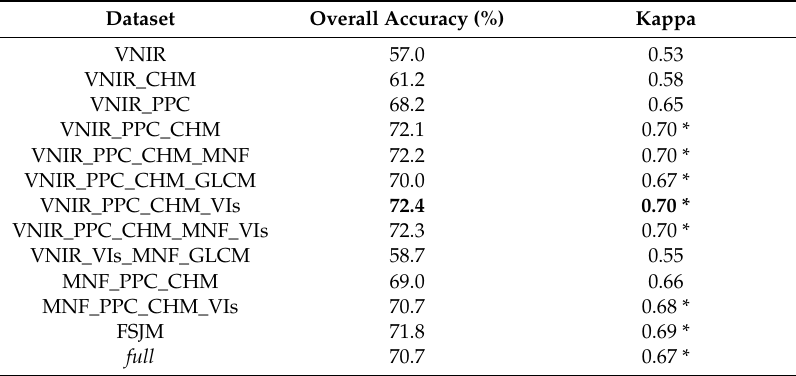
Table 7. Overall accuracy and Kappa index for each dataset associated with the support vector machine (SVM) classifier.